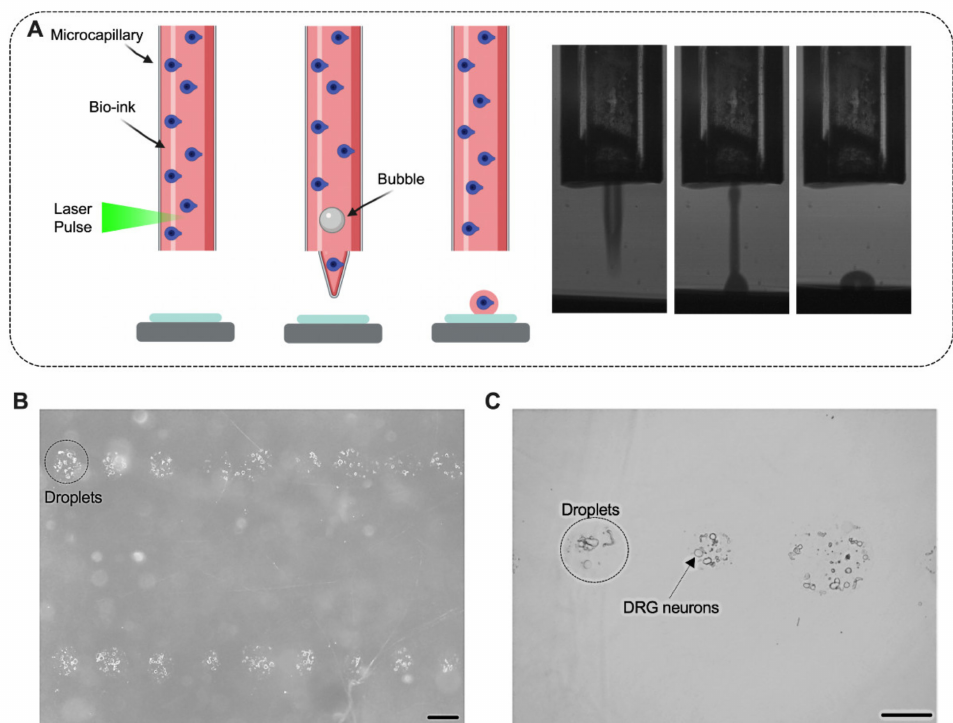
Figure 1. Laser-induced side transfer (LIST) of neurons. Schematic representation of the printing system ( A left) and indicative high-speed imaging of bioink ejection ( A right). Printed droplets with DRG neurons 1 h after printing. ( B , C ). Scale bar = 50 µ M ( B , C